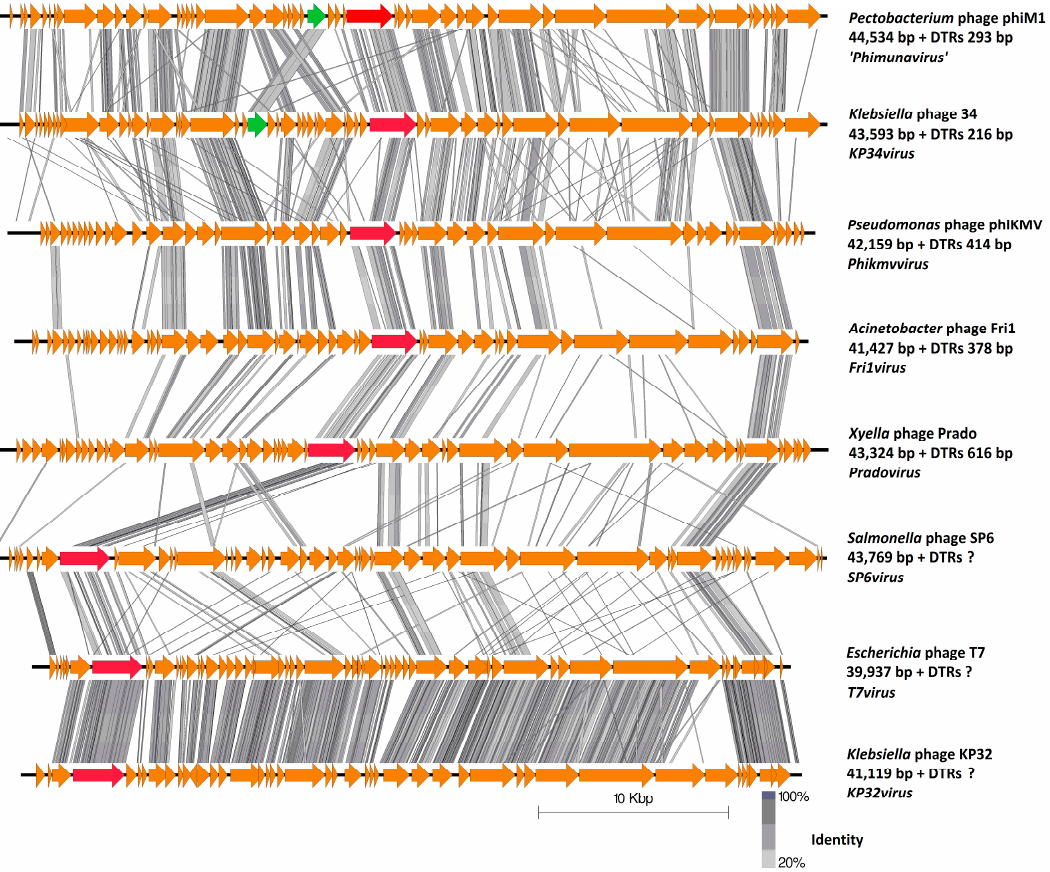
Table S4). Further analysis using Gegenees (TBLASTX), based on protein similarity, indicate the PhiM1-like phages form a clade with high identity values of ≥ 80%. Additionally, as seen in the phylograms, it was observed that P. carotovorum subsp. carotovorum phages PP16 and PPSW1 and Dickeya phage BF25/12 share an evolutionary relationship with PhiM1-like phages (identity values ≥ 54%) (Figure 7). Viruses 2018 , 10 , x FOR PEER REVIEW